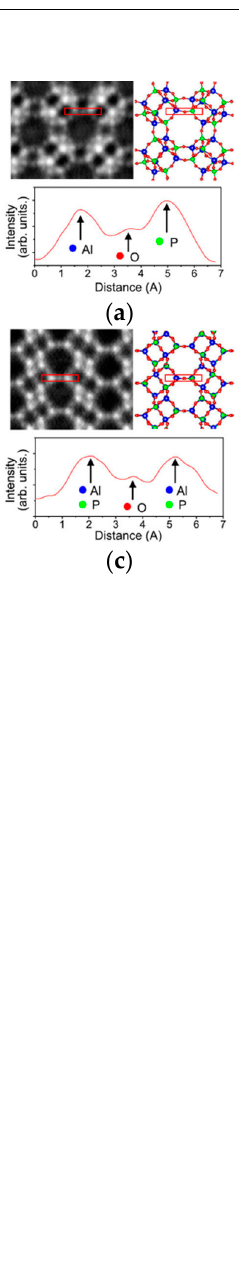
12 of 24 Figure 13. ( a , b ) iDPC-STEM image ( b , top ), the structural model ( b , middle ) and the simulated im- age ( b , bottom ); ( c ) shows the corresponding intensity profile acquired from the red-framed region in ( a ).Reprinted/adapted with permission from Ref. [102]. Copyright 2021, Springer Nature. Silicoaluminophosphate (SAPO) molecular sieves with small pores, such as SAPO- 34 and SAPO-18, play an important catalytic role in methanol-to-olefin (MTO) reactions. Among them, molecular sieves with SAPO-18/SAPO-34 eutectic structure often show bet- ter performance than single molecular sieves in catalytic reactions due to the presence of both AEI and CHA structural units. However, due to the difficulty of electron microscopy characterization, SAPO-18 The /SAPO-34 eutectic structure is less studied. In Figure 14a– d, a local enlargement of an iDPC-STEM image of SAPO-18 (AEI) and SAPO-34 (CHA) from different orientations reveals the projection of the different bond lengths of Al-O and P-O bonds in different directions combined with their intensity profiles. This provides